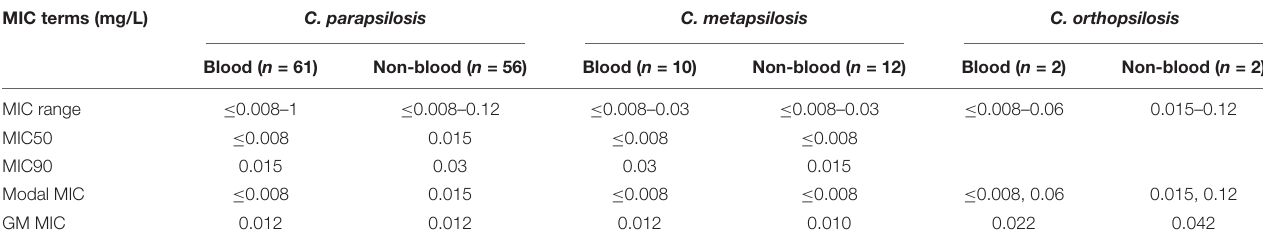
FIGURE 2 | Comparison of the proportions of minimum inhibitory concentration (MIC) distributions of bloodstream C. parapsilosi s isolates between 2005–2018 and 2019–2020. *Indicates 0.01 < P < 0.5, statistically significant differences of MIC values between 2005–2018 and 2019–2020; **indicates 0.001 < P < 0.01, ***indicates P < 0.001. FLZ, fluconazole; VRZ, voriconazole; ITZ, itraconazole; POZ, posaconazole; MFG, micafungin; AFG, anidulafungin; CAS, caspofungin; AMB, amphotericin B; FCY, 5-flucytosine. TABLE 3 | In vitro susceptibilities to isaconazole of the 143 C. parapsilosis complex